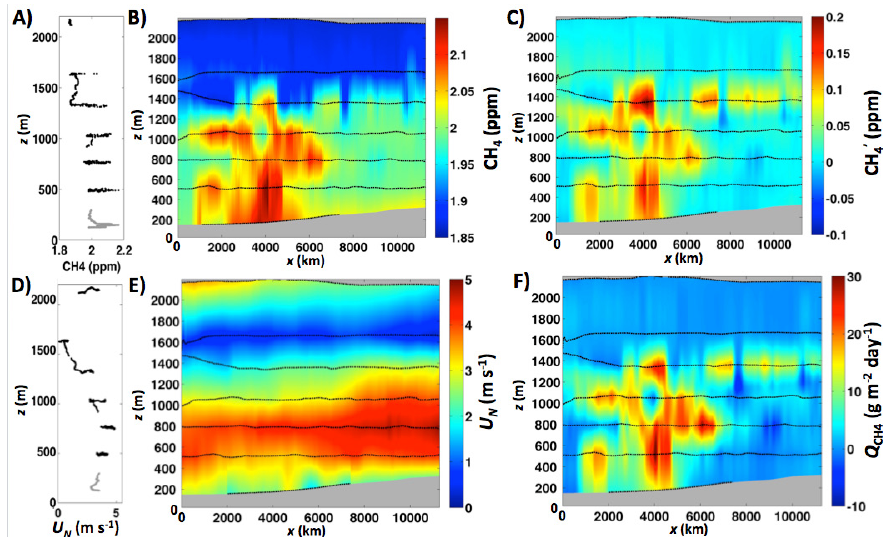
Figure A2. (A) Downwind methane (CH 4 ) vertical profile with altitude ( z ) for Kern Front oil field transect (Figure A1) on 4 September 2014, and (B) Transect curtain, vertically-interpolated CH 4 ( x , z ), where x is easting distance relative to 119.0411°W, 35.3972°N. Dashed line shows data locations with gray for ground and above airborne data. Where surface data were unavailable, surface values were extrapolated from C AMOG /C CIRPAS(500 m) and (C) CH 4 anomaly (CH 4 ′( x , z )) based on background subtraction, (D) plane-normal wind profile ( U N ( z )), as in panel A, (E) transect curtain U N ( x , z ) and (F) transect curtain of CH 4 flux ( Q CH4 ( x , z )). Data key on panels.